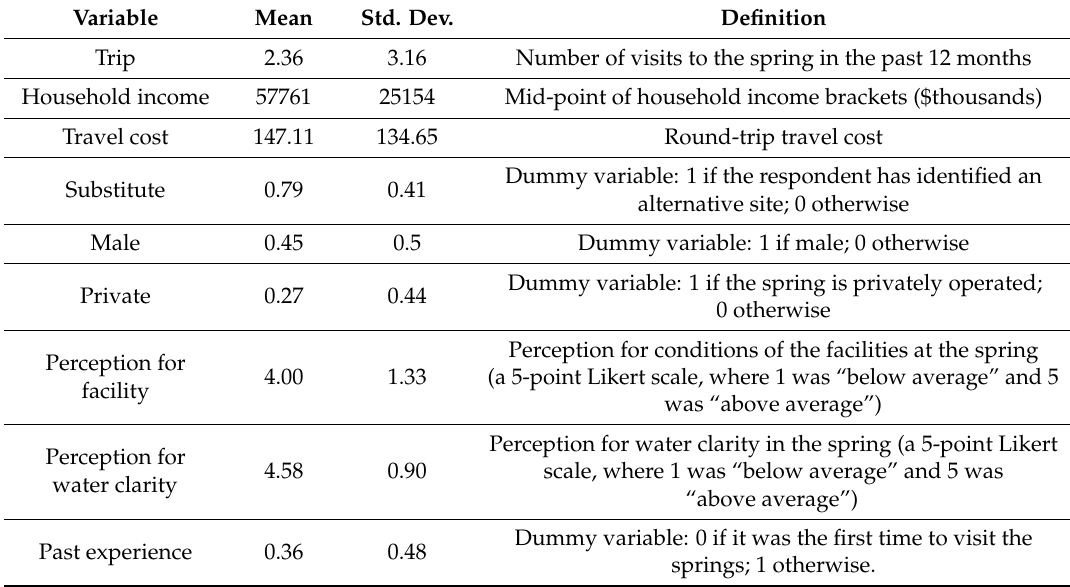
Table 2. Summary statistics for